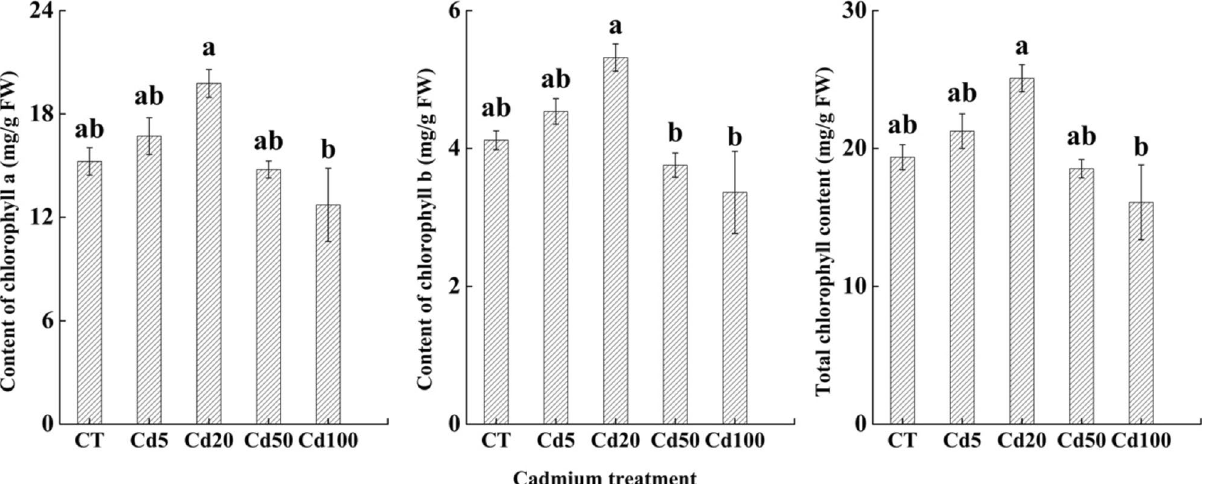
Figure 4. Chlorophyll content of sassafras leaves under different concentrations of